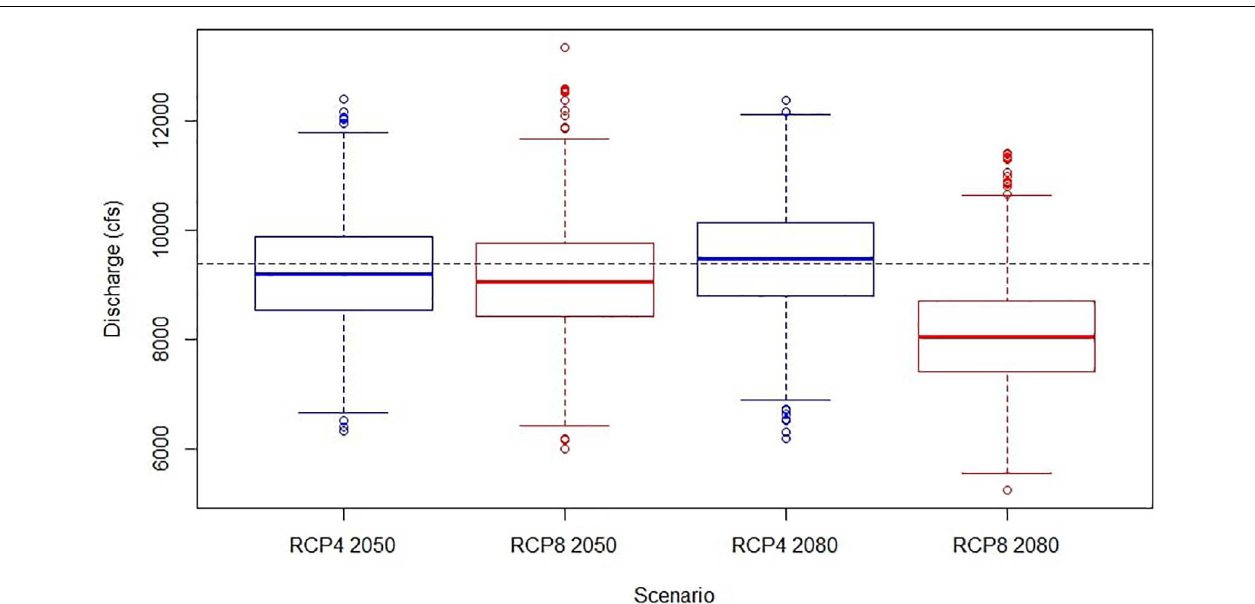
FIGURE 3 | Mean annual discharge from the projected long-term simulations. Similar ranges of discharge are demonstrated for RCP 4/8 2050 and RCP 4 2080. Projections in RCP 8 2080 are noticeably lower, where a 13% decrease in mean discharge was observed from the current condition. TABLE 3 | Mean and standard deviation of discharge for short-term and long-term model scenarios. Group Dry Norm Wet Low Var. High Var. Mean Discharge 4326 −